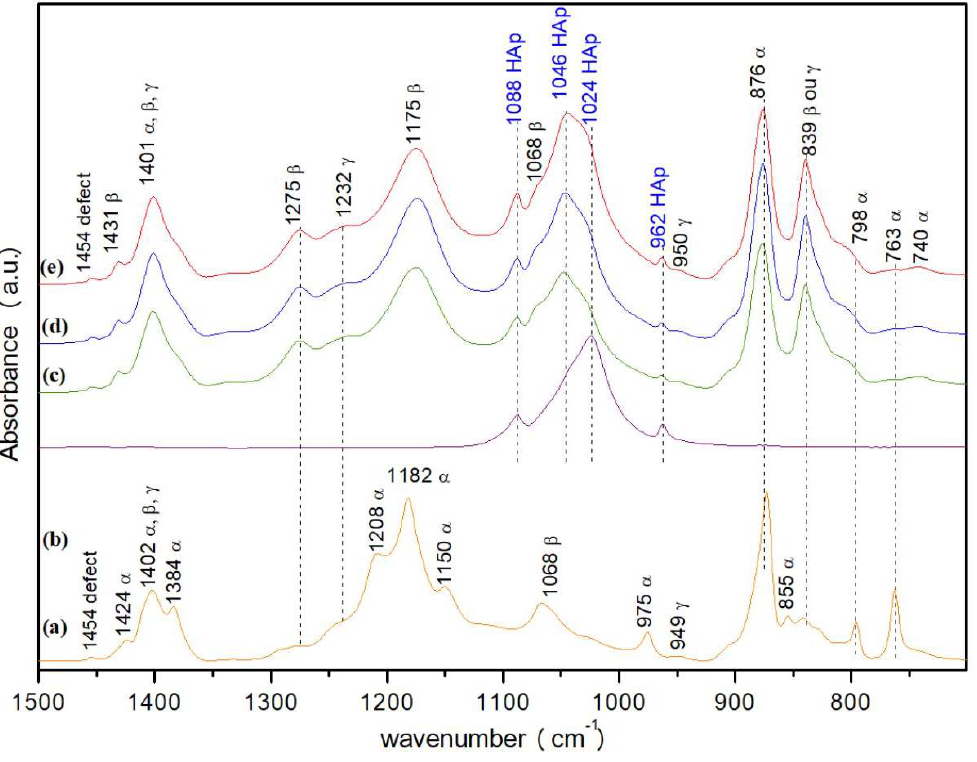
Figure 5. Absorbance ATR-FTIR spectra for ( a ) PVDF and ( b ) HA powders, ( c ) P14-H10, ( d ) P14-H15, ( e ) P14-H20 scaffolds.